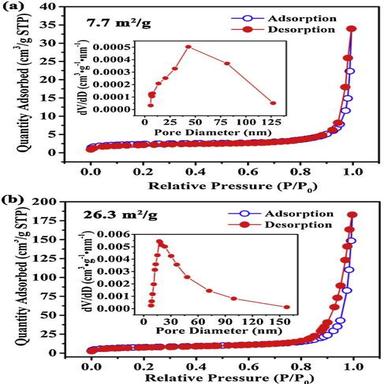
N2 adsorption-desorption isotherms and pore size distribution of (a) ZnO hollow nanomeshes; and (b) ZnO/ZnFe2O4 composites.